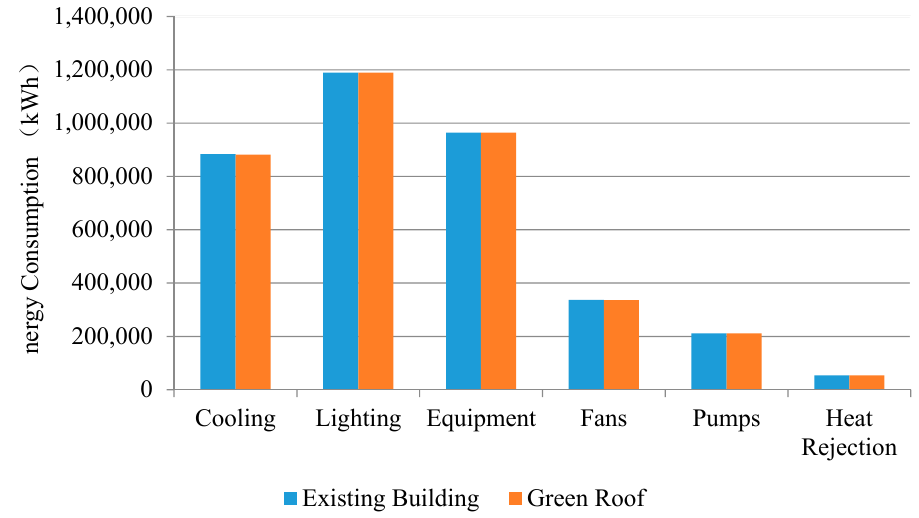
Figure 7. Annual energy consumption before and after the roof retrofit.